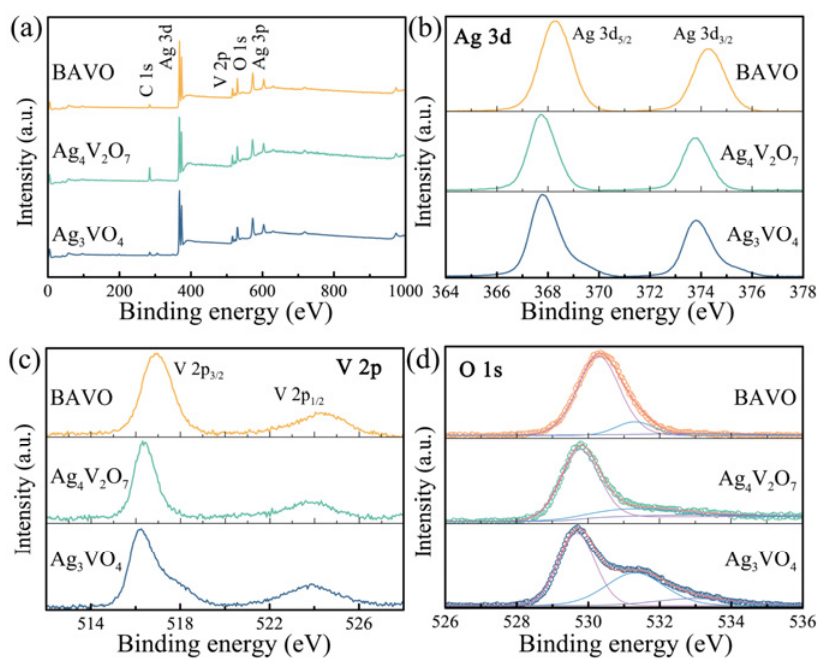
Fig. 4 XPS spectra of Ag 3 VO 4 , Ag 4 V 2 O 7 , and BAVO heterojunction: (a) survey scan, (b) Ag 3d, (c) V 2p, and (d) O 1s.